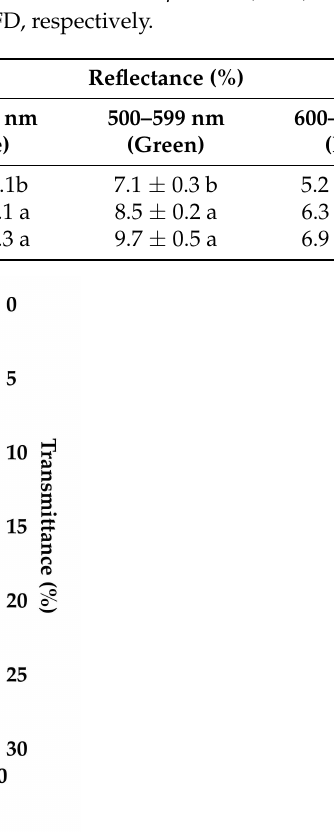
Table 4. Effects of PPFD on the transmittance and reflectance of leaves in ‘Micro-Tom’ at blue, green, and red wavelengths 10 DAT in Experiment 1. The range of measured light spectrum was 400–700 nm. Each value represents the mean ± standard error. Different letters in a column indicate significant differences among the treatments based on the Tukey − Kramer’s test at p < 0.05 ( n = 8). W300, W500,